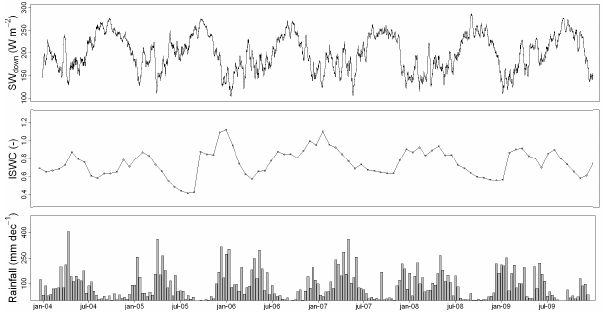
Fig. 3. Seasonal patterns in SW down , index of soil water content (ISWC) and rainfall at Guyaflux over 2004–2009 (data from Bonal et al., 2008 and from this